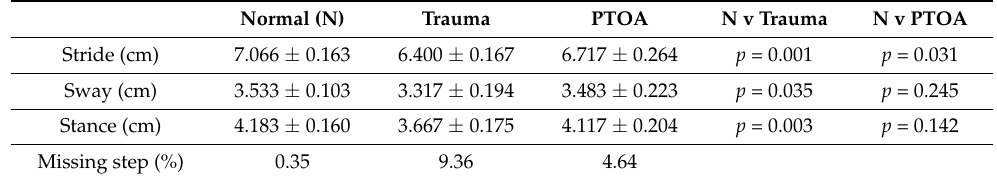
Figure 7. Behavior analyses of control and experimental animals. ( A ) Gait analysis. Observe the difference in stance, stride, and sway among the ( i ) normal, ( ii ) trauma and ( iii ) PTOA groups. (Blue arrows indicate the missing step/asymmetric gait patterns). Open-field analysis between unloaded control and mechanical loaded mice. ( B ) Travel distance and ( C ) rearing activity. Data are represented as mean ± SD. * p < 0.05 (noML vs. ML). ( n = 6 per group). Table 1. Gait analysis using mice foot-print (Figure 7A). Missed-step rates were calculated by number of missed steps divided by total number of steps.